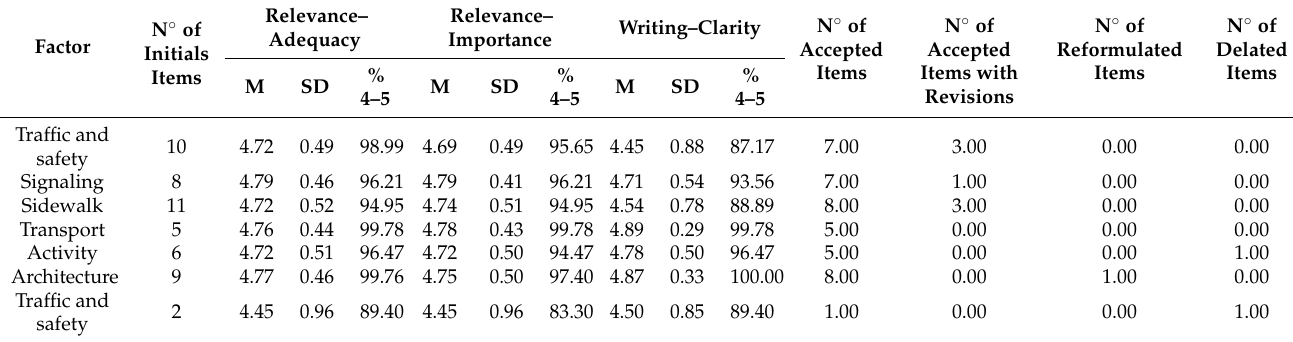
Table 6. Summary of results of the second round by